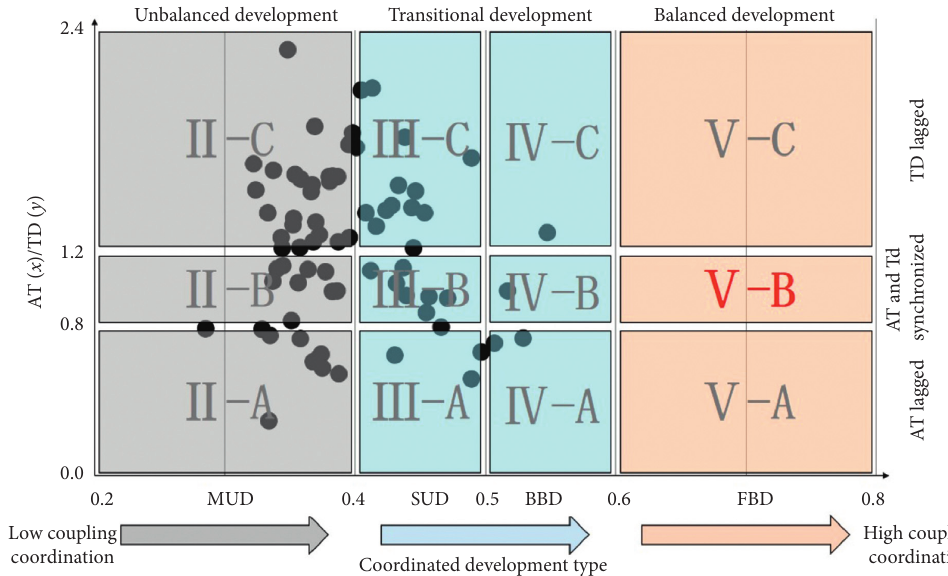
Figure 6: Evolution of the coordinated development types of ATTD. Note: T T